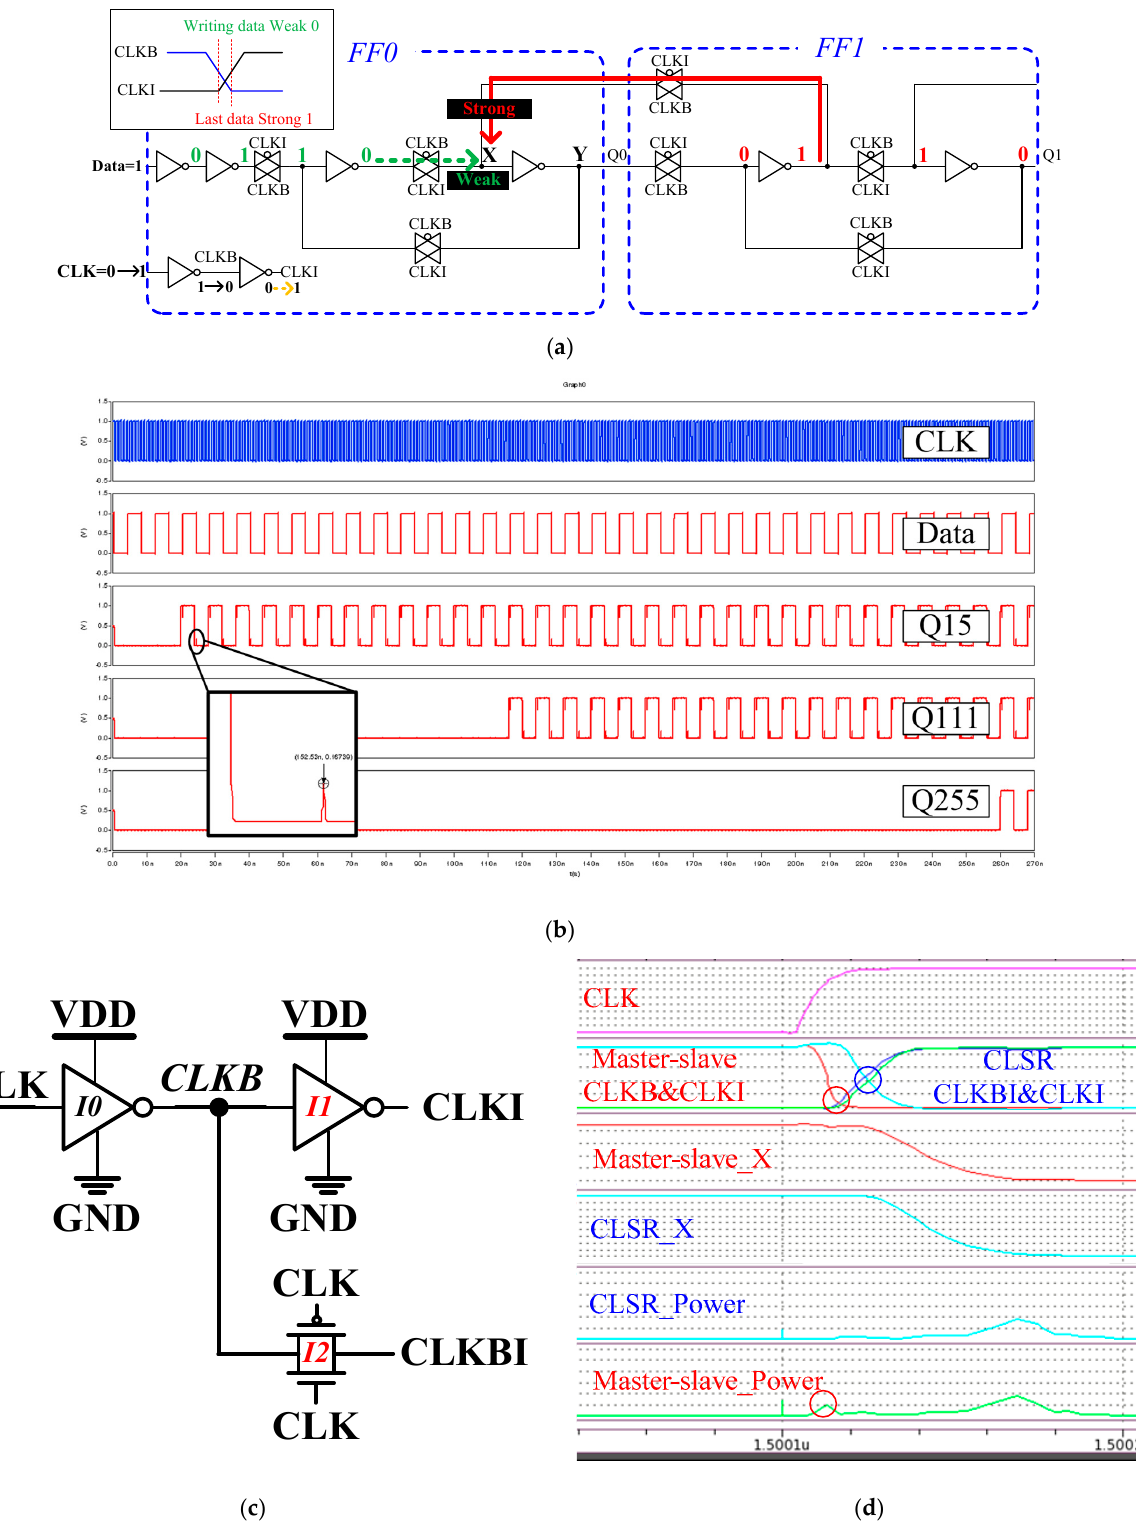
Figure 6. ( a )–( b ) Glitch issue of the proposed CLSR design. ( c )–( d ) Proposed delay clock circuit. Figure 6. ( a , b ) Glitch issue of the proposed CLSR design. ( c , d ) Proposed delay clock circuit. Figure 6a shows a specific situation caused by the rising edge of the clock. As the clock driver changes its phase from low to high, it produces a short phase difference between the rising edge and falling edge, so that CLKB and CLKI achieve equal potential. The previous data feedback path (red) is stronger than the current input data path (green). Therefore,